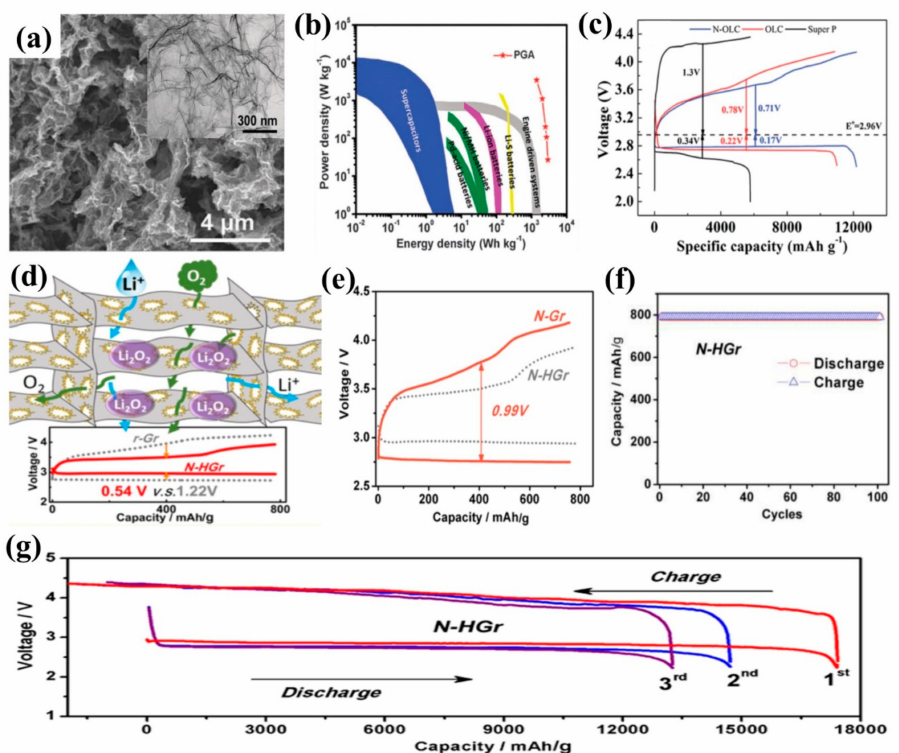
Figure 5. ( a ) SEM and TEM images of polystyrene sphere mediated ultra-thin graphene sheet assembled aerogel (PGA). ( b ) Ragone diagram of lithium oxygen battery with PGA as air electrode (based on the total mass of C + Li 2 O 2 ). Reprinted with permission from ref. [69]. Copyright 2015 Royal Society of Chemistry. ( c ) First discharge/charge curve of lithium oxygen battery with NOLC, OLC and super P electrodes at 0.15 mA cm − 2 . Reprinted with permission from ref. [73]. Copyright 2016 Royal Society of Chemistry. ( d , e ) Discharge/charge distribution of N-doped porous graphene (N-HGr), original graphene (r-Gr) and original porous graphene (r-HGr) at 40 mAg − 1 . ( f ) Cycling stability of N-HGr with a limited capacity of 800 mA h g − 1 with a current density of 40 mA g − 1 . ( g ) Three full discharge/charge cycles of N-HGr within a voltage window of 2.2–4.4 V under a current density of 100 mA g − 1 . Reprinted with permission from ref. [37]. Copyright 2016 American Chemical